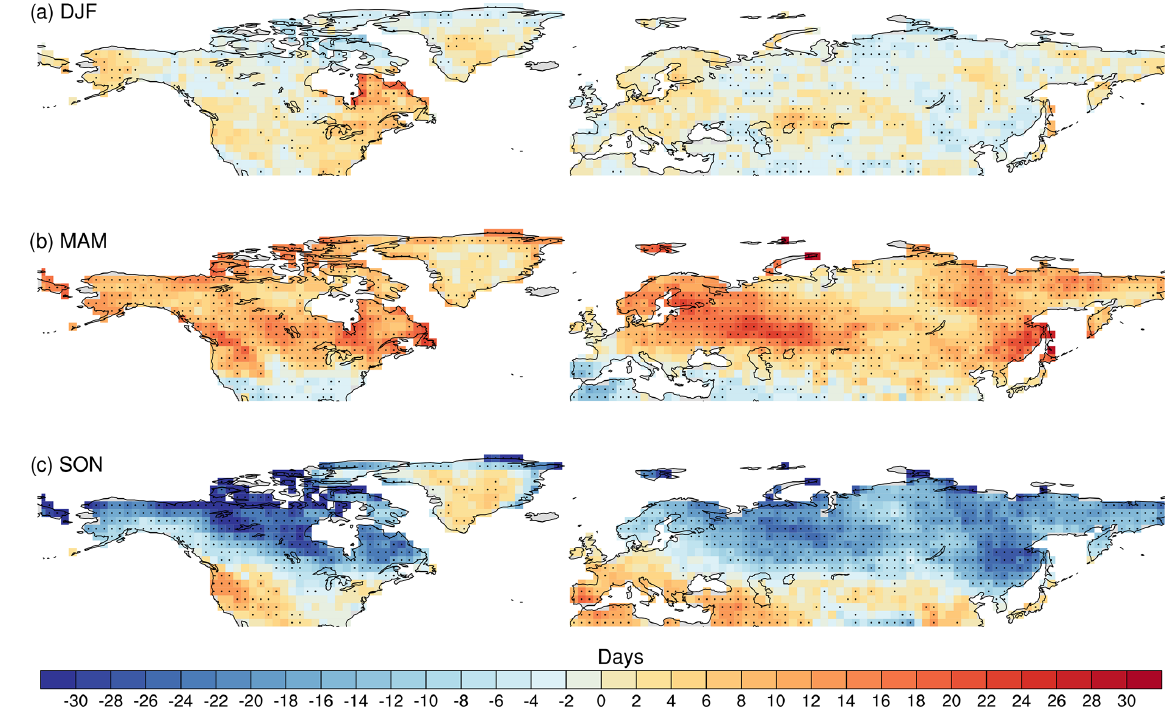
Figure 6. Projected changes in the timing of the anomalously coldest day of the season between 2070–2099 and 1950–1979 in the six- member CMIP5 multi-model mean for boreal winter (a) , spring (b) and autumn (c) . Positive values indicate grid cells where the anomalously coldest day occurs later in the season, while negative values indicate grid cells where the anomalously coldest day occurs earlier in the season. Stippling indicates where at least five out of the six models agree on the sign of